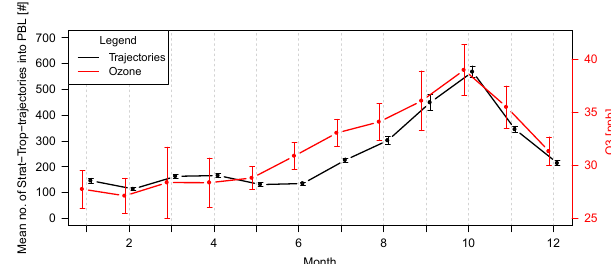
Figure 8. Mean annual cycle over 19 years (1996–2015) of ozone at TLL and of trajectories indicating STE above TLL. For better readability, the monthly means for both variables have been shifted by ± 6